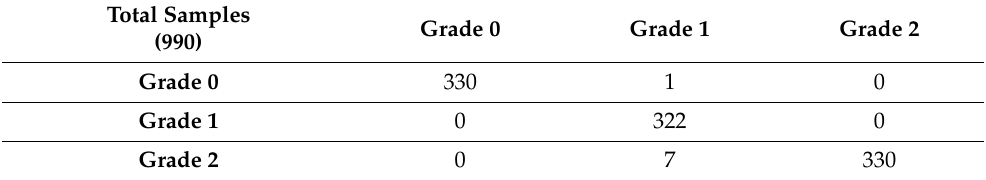
Table 7. Testing confusion matrix of SGDM empowered with AlexNet (augmented test data).